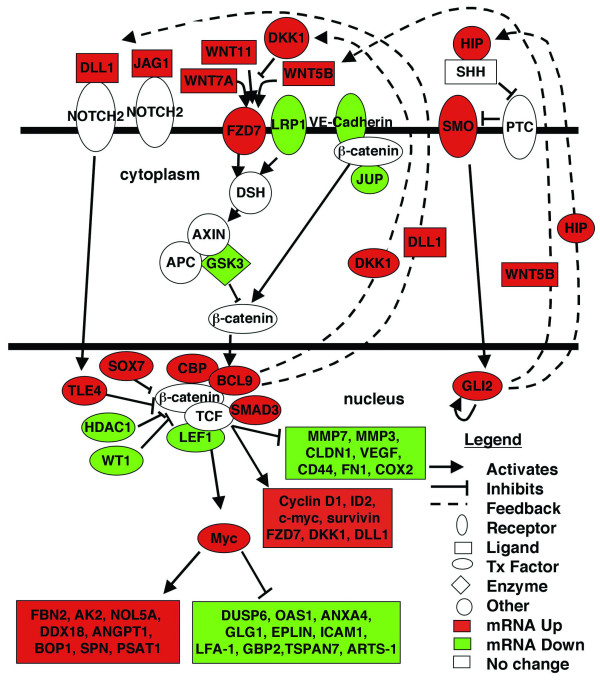
Impact of SV40 ST on the Notch, Wnt, and Hedgehog Pathways. Schematics of the Notch, Wnt, and Hedgehog pathways are shown. Genes with significantly increased mRNA's in HEK-TERST cells compared to HEK-TERV cells are shown in red, while genes significantly decreased are shown in green. Sets of downstream targets of the Wnt pathway are grouped in boxes, as are sets of c-myc downstream targets. Activation of the Hedgehog pathway due to increased HIP, SMO, and GLI2 levels results in increased Wnt ligand expression. Activation of Wnt signaling increases c-myc, activating and repressing multiple downstream target genes. Wnt pathway activation also feeds back to activate expression of Notch ligands such as DLL1.